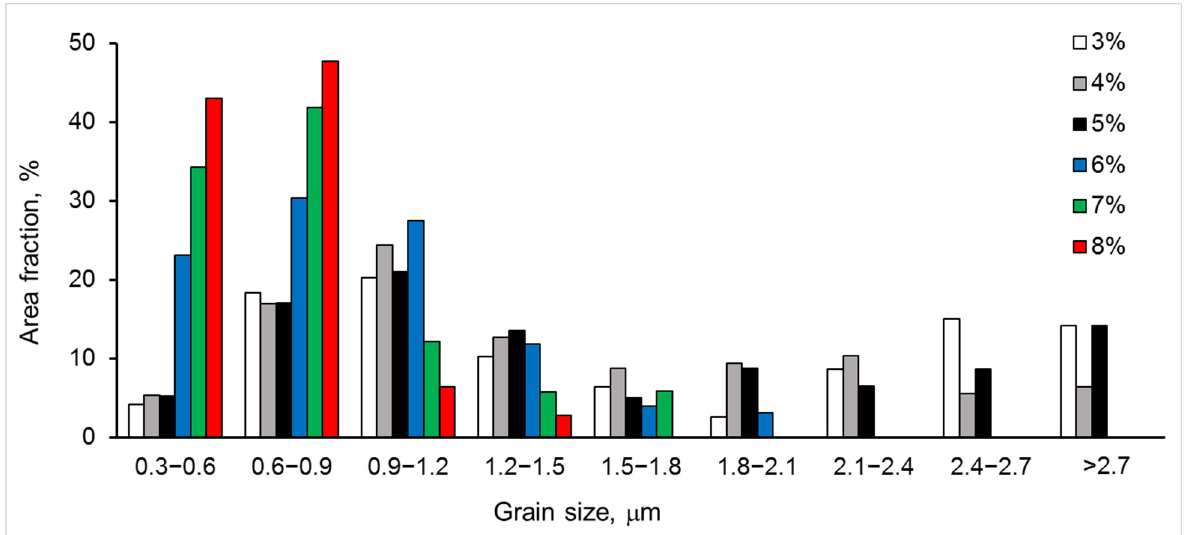
Figure 4. Grain size distributions for six studied materials with 3–8% Y 2 O 3